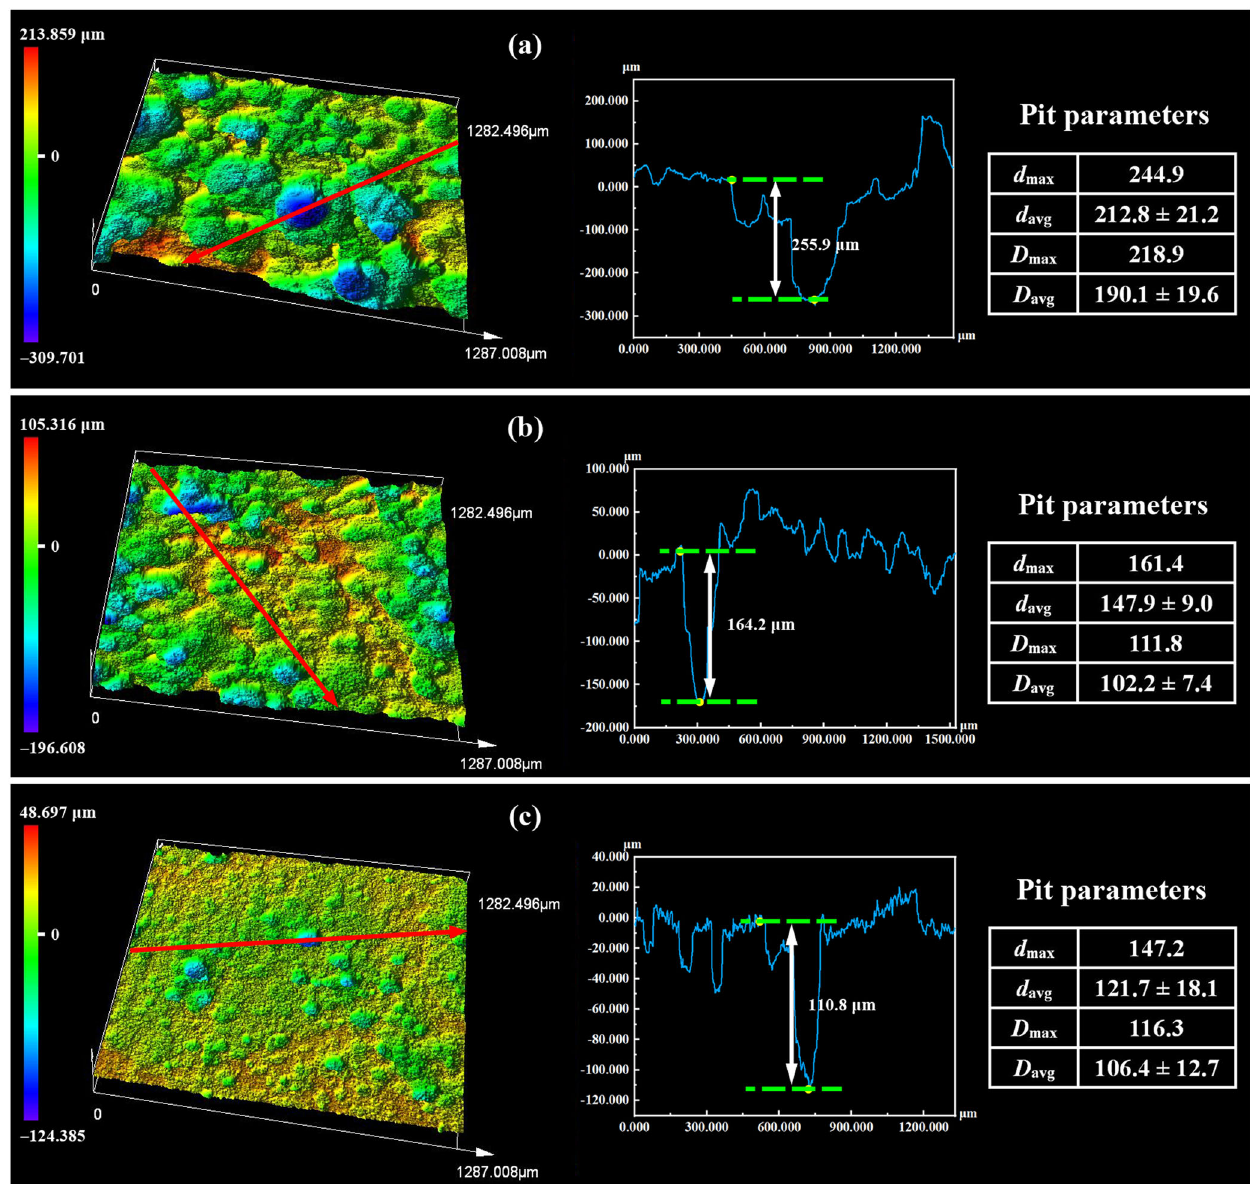
Fig. 2 CLSM images and corrosion pit parameters of the coupons after exposure to the tidal zone. CLSM images and corrosion pit parameters for the AISI 4135 steel coupons after exposure to the a HTL, b MTL and c LTL for 3